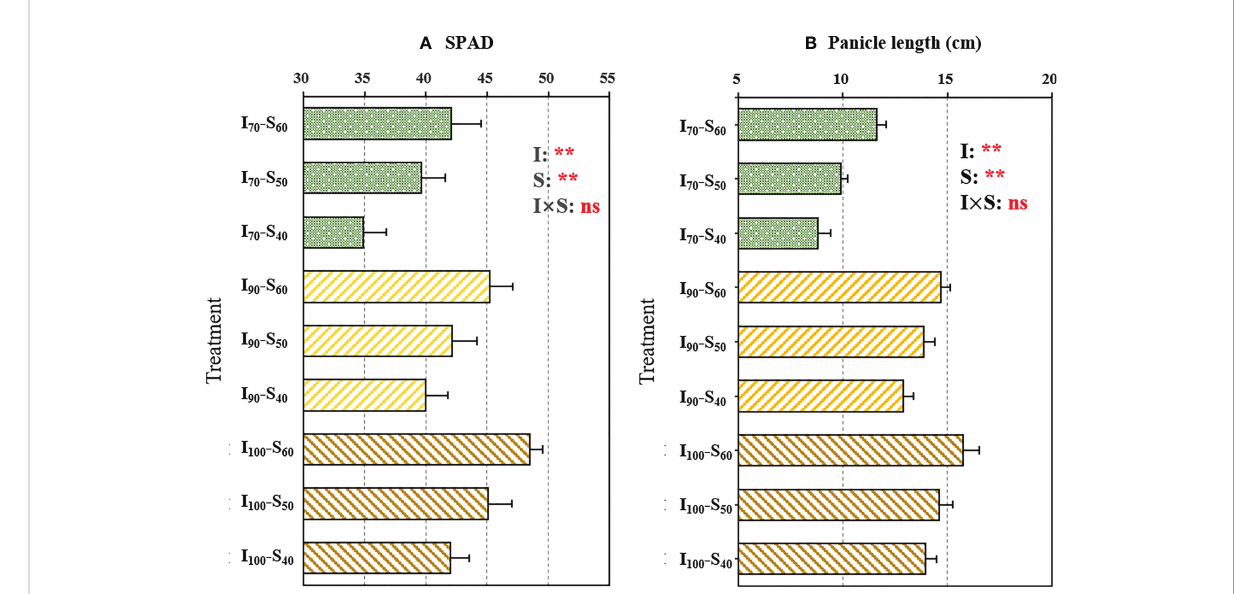
FIGURE 1 The output of two-way analysis of variance (ANOVA) for (A) SPAD readings of fl ag leaves and (B) panicle length as in fl uenced by different water regimes and soil clay contents (mean ± SD; n = 4). I 70 , I 90 and I 100 represent irrigation regimes of fl ooding with 30mm (upper limit) as the soil water reaches 70% of saturation (lower limit); fl ooding with 30mm (upper limit) as the soil water reaches 90% of saturation (lower limit) and fl ooding with 30mm (upper limit) as the soil water reaches 100% of saturation (lower limit). S 40 , S 50 , and S 60 indicate soil clay content with 40%, 50% and 60% respectively. I, S, and I×S indicate irrigation regime, soil type, and the interaction between irrigation regime (I) and soil type (S), respectively. ns and ** represent no signi fi cance and p <0.01, respectively.